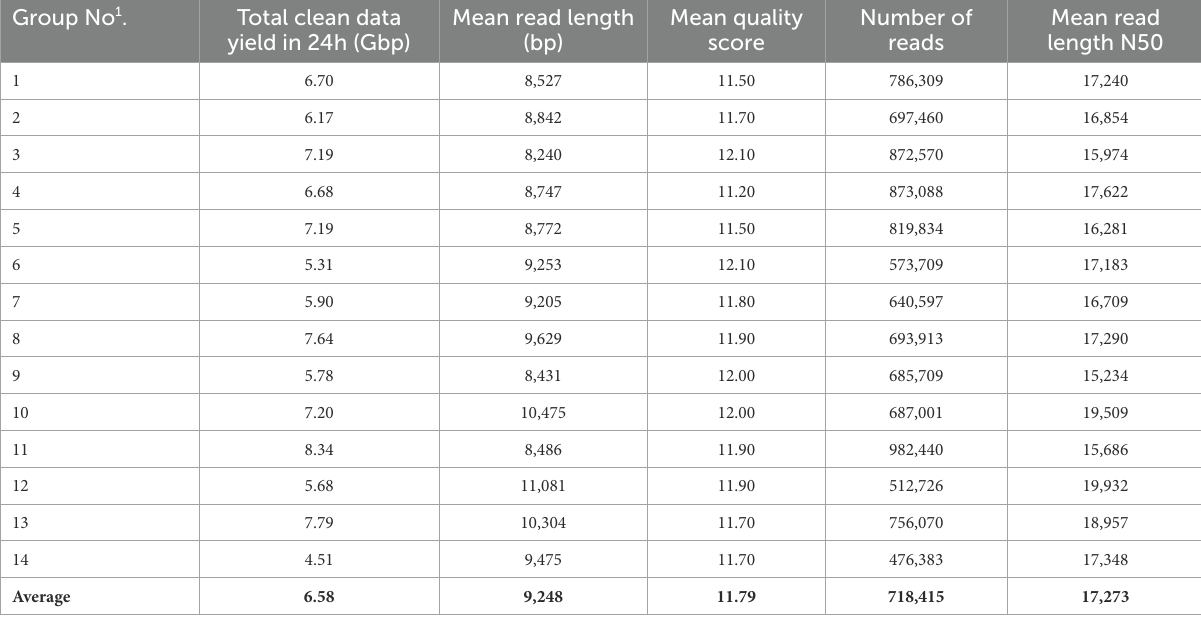
TABLE 2 Statistics of ONT multiplex sequencing data for each group of isolates tested from 24 h of sequencing. Group No 1